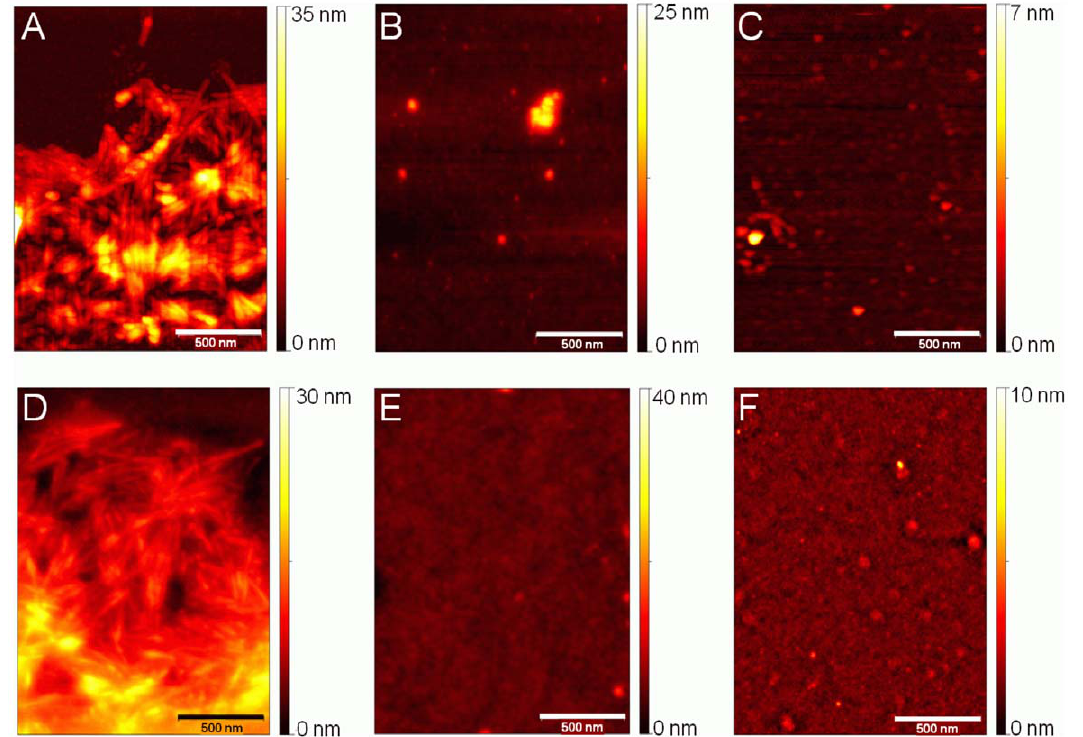
Figure 4. AFM analysis of a -syn aggregation in the presence or absence of both ThT and DOP. AFM height images were acquired from assay end products, which had been deposited onto freshly cleaved mica surfaces after 100 hours of incubation. The presence or absence of ThT revealed no observable effect upon either the formation or morphology of a -syn fibrils when assay was run with a syn alone, (A) + ThT, (D)–ThT. The inhibitory effect of DOP on the a syn fibrillization was clearly observed when the assay was run in the presence of DOP. (B, C, E, F). Moreover, the presence (B, C) or absence (E, F) of ThT did not show any effect upon the inhibitory action of DOP on a -syn fibrillization.